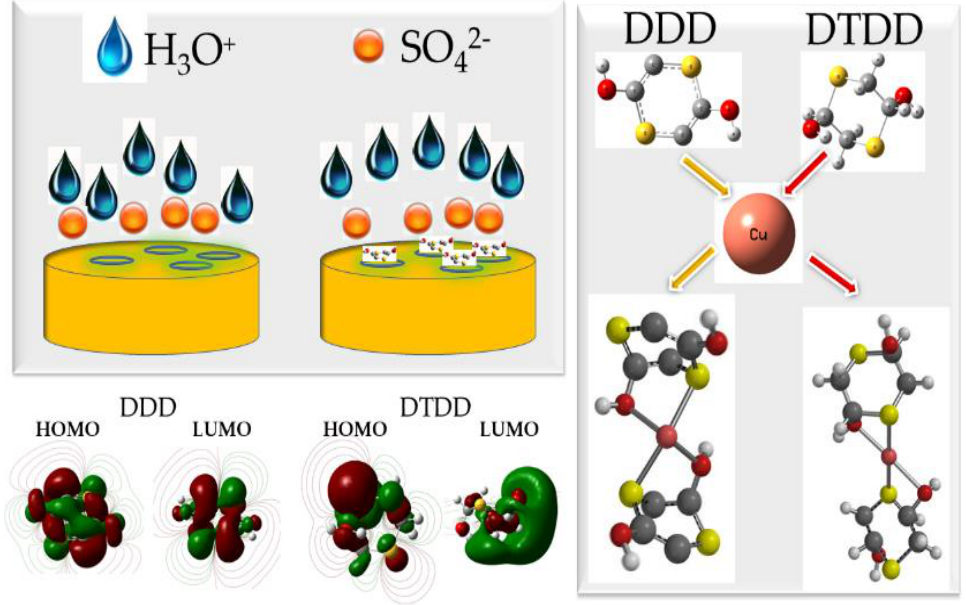
Figure 8. Absorption of DDD and DTDD mechanism onto copper.